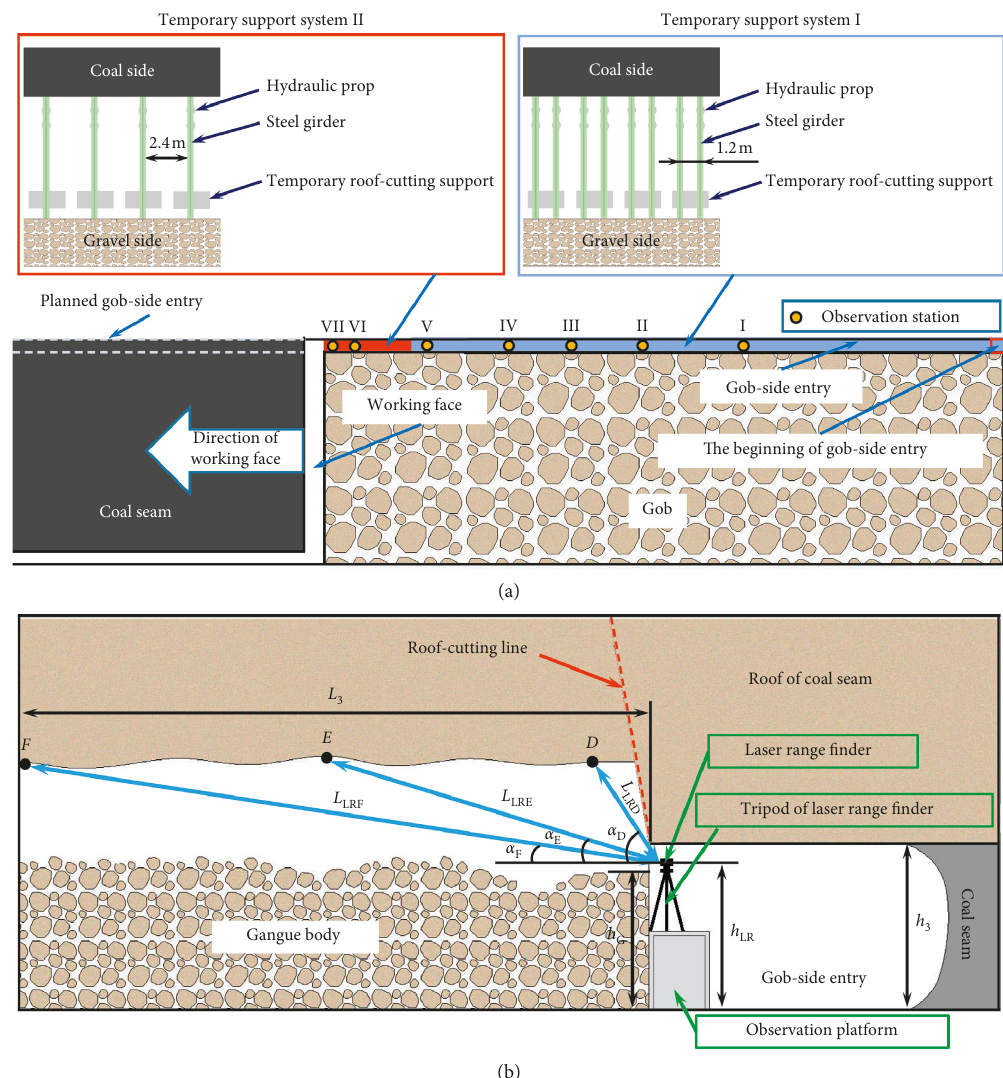
Figure 9: Diagram of the field monitoring scheme. (a) Diagram of the layout of the observation stations. (b) Diagram of the field ob- servations in the monitoring